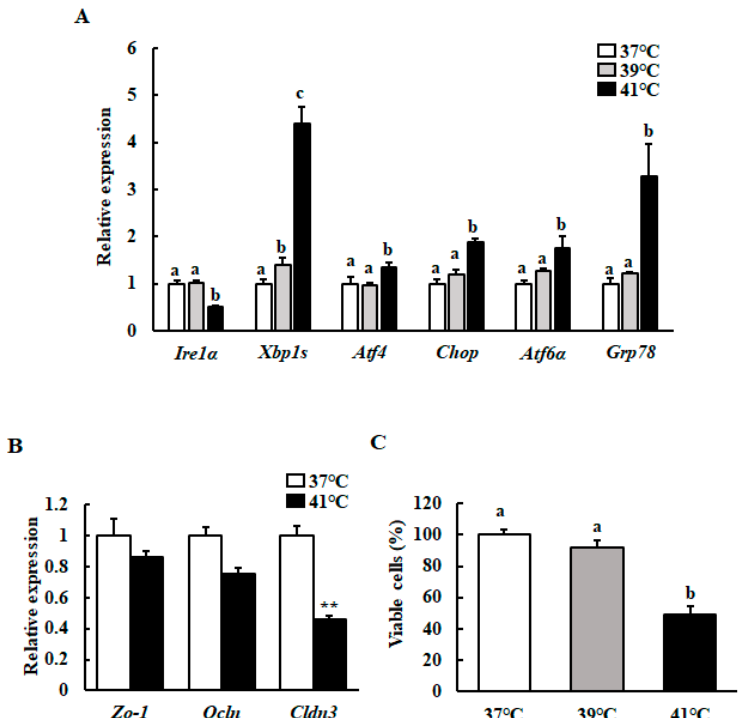
Figure 1. E ff ect of di ff erent temperatures on the mRNA levels of the UPR- and TJ protein-related genes, as well as on cell viability. After reaching 90%–100% confluence, HC11 cells were incubated at 37 ◦ C (control), 39 ◦ C for 72 h, or 41 ◦ C for 6 h. ( A ) The mRNA level of Ire1 α , Xbp1s , Atf4 , Chop , Atf6 α , and Grp78 were determined using RT-qPCR and normalized to that of GAPDH. ( B ) The mRNA level of Zo-1 , Ocln , and Cldn3 were determined using RT-qPCR and normalized to that of GAPDH. ( C ) Cell viability was measured using an MTT assay. The results are expressed as the mean values ± SEM for four independent experiments. Means with different letters are significantly different, p < 0.05. ** p < 0.01 compared to the control.